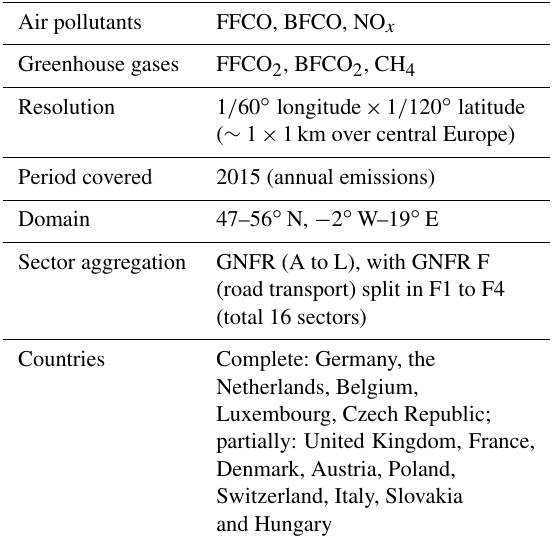
Table 1. Characteristics of the high-resolution emission inventory TNO GHGco v1.1 containing fossil fuel (FF) and biofuel (BF)